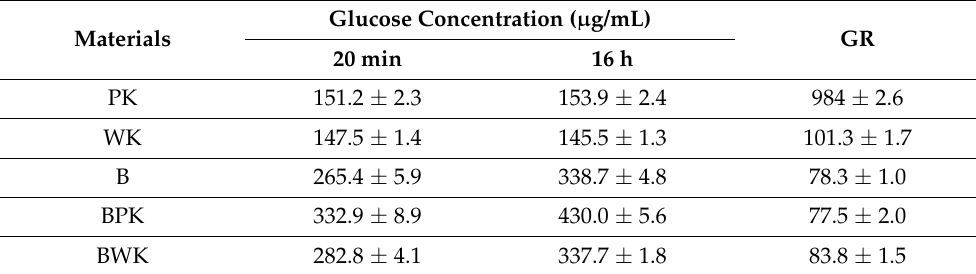
Table 5. Glucose releasing rate of test foods. Values are presented as mean ± SEM ( n =